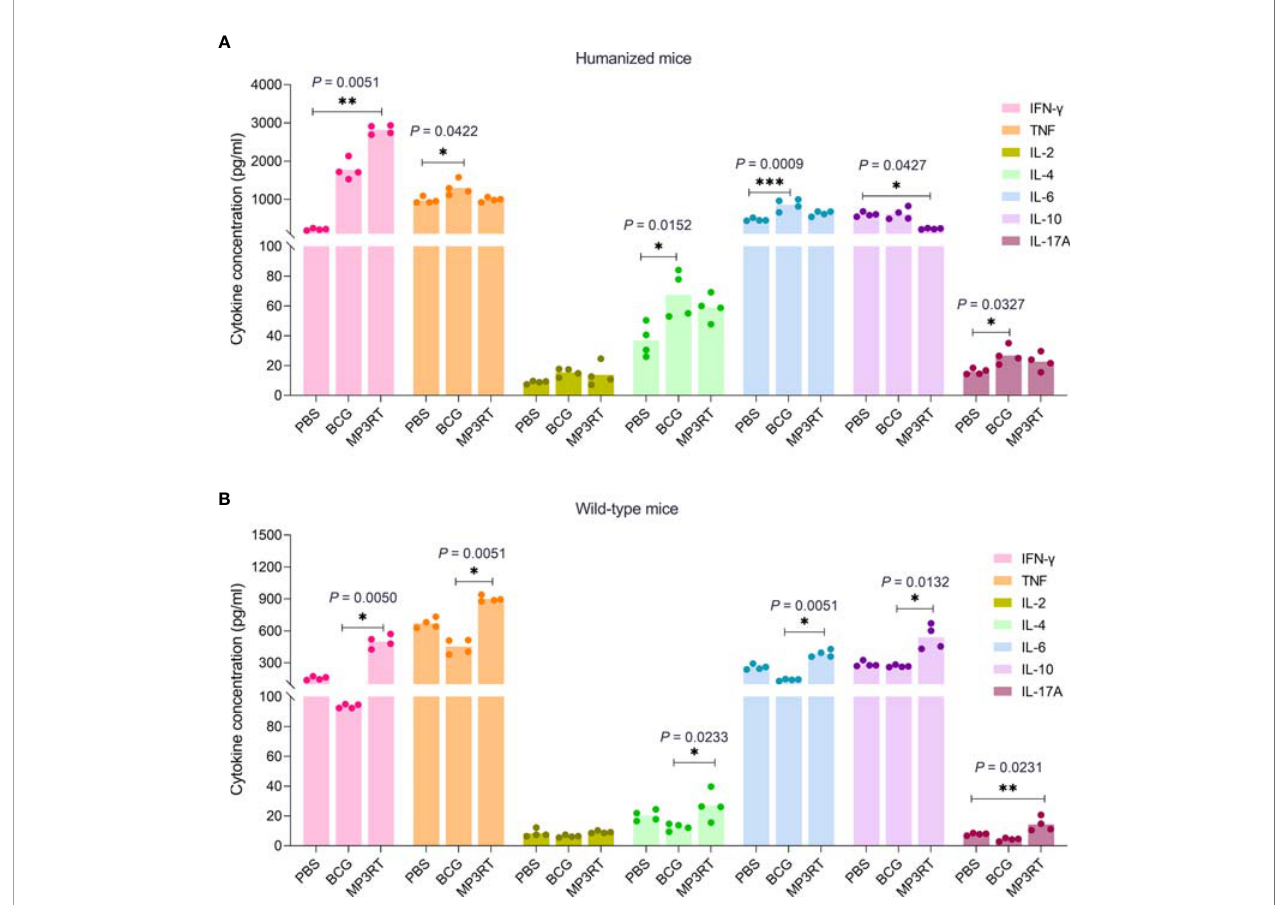
FIGURE 7 | Cytokines. The splenocytes isolated from humanized mice (A) or wild-type mice (B) immunized with PBS, BCG, or MP3RT were stimulated with the MP3RT vaccine for 48 hours. The levels of IFN- g , TNF- a , IL-2, IL-4, IL-6, IL-10, and IL-17A cytokines in the supernatant were detected with a Mouse Th1/Th2/Th17 Cytokine Kit. The differences were compared with the one-way analysis of variance (ANOVA) or Kruskal-Wallis test according to the data normality and homogeneity of variances. All data were shown as mean + SEM ( n = 4). P < 0.05 was considered signi fi cantly different. * P < 0.05; ** P < 0.01; *** P <